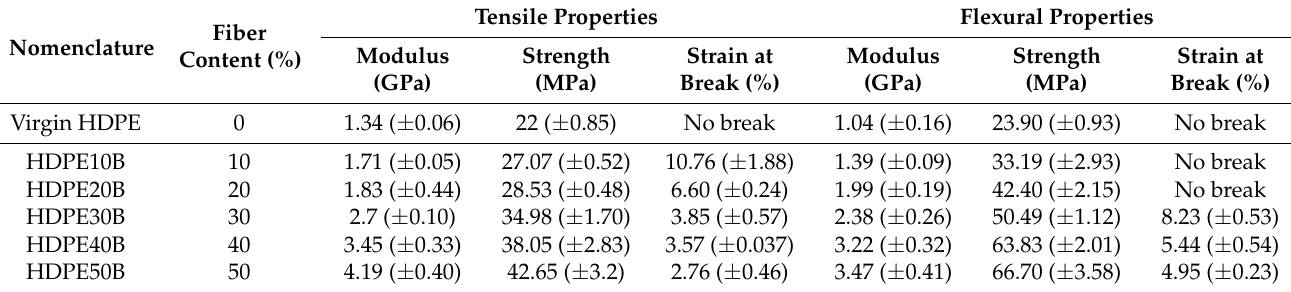
Table 2. Mechanical properties of HDPE/birch fiber composite material.